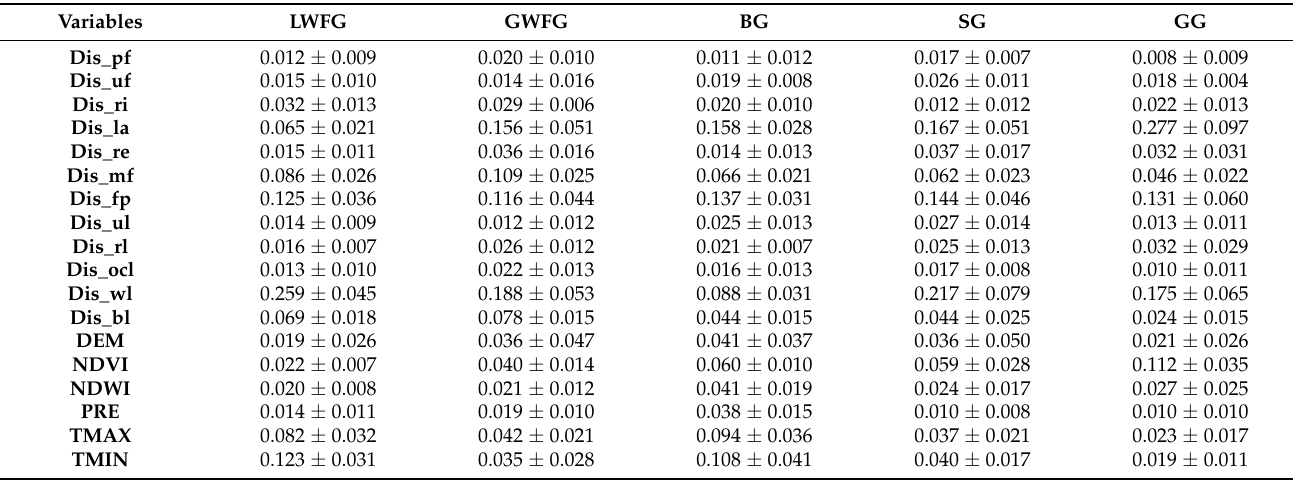
Table A1. Variable importance of 18 environmental variables of the GAM algorithm.